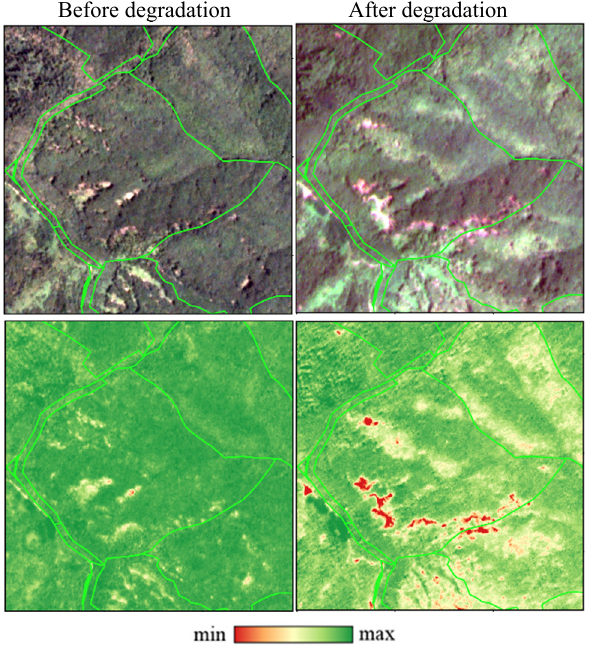
Figure 2. True-colour composite (above) and NDVI (below) before and after forest degradation for forest compartment/subcompartment 17A.